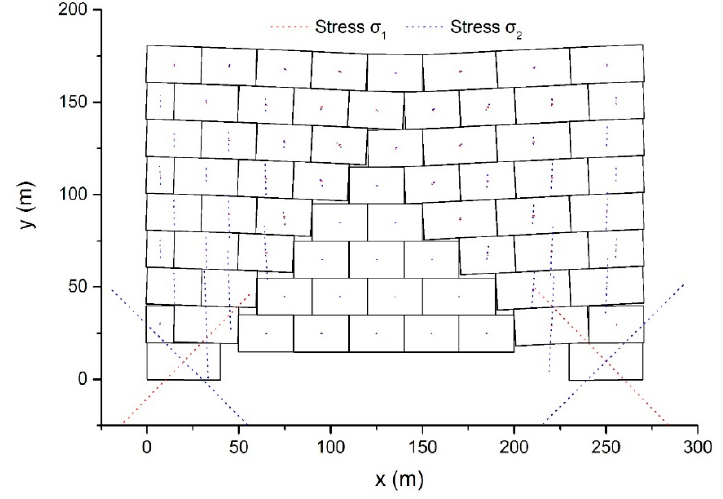
Figure 13. The configurations and main stress vectors after 7 s by DDA with the post-adjustment strategy.